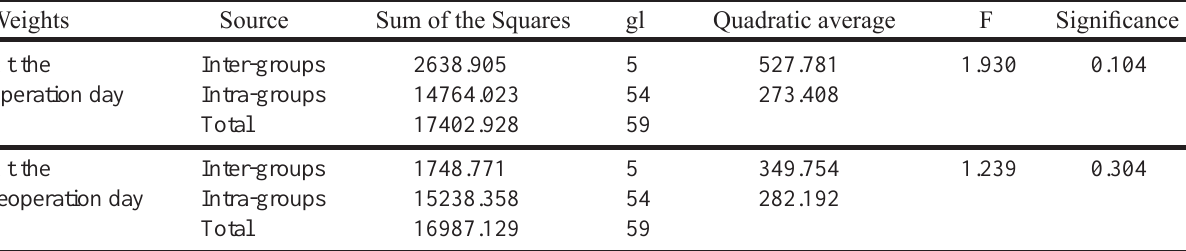
TABLE 2 - Analysis of variance applied to weight of animals measured at the operation and at the re-operation days